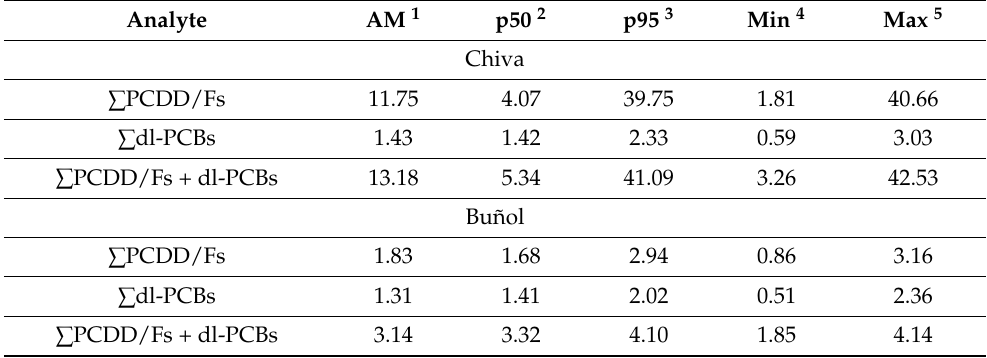
Table 1. Overall concentrations (fg TEQ/m 3 ) (particulate and gaseous phase) in ambient air samples at Chiva (n = 13) and Buñol (n = 10).